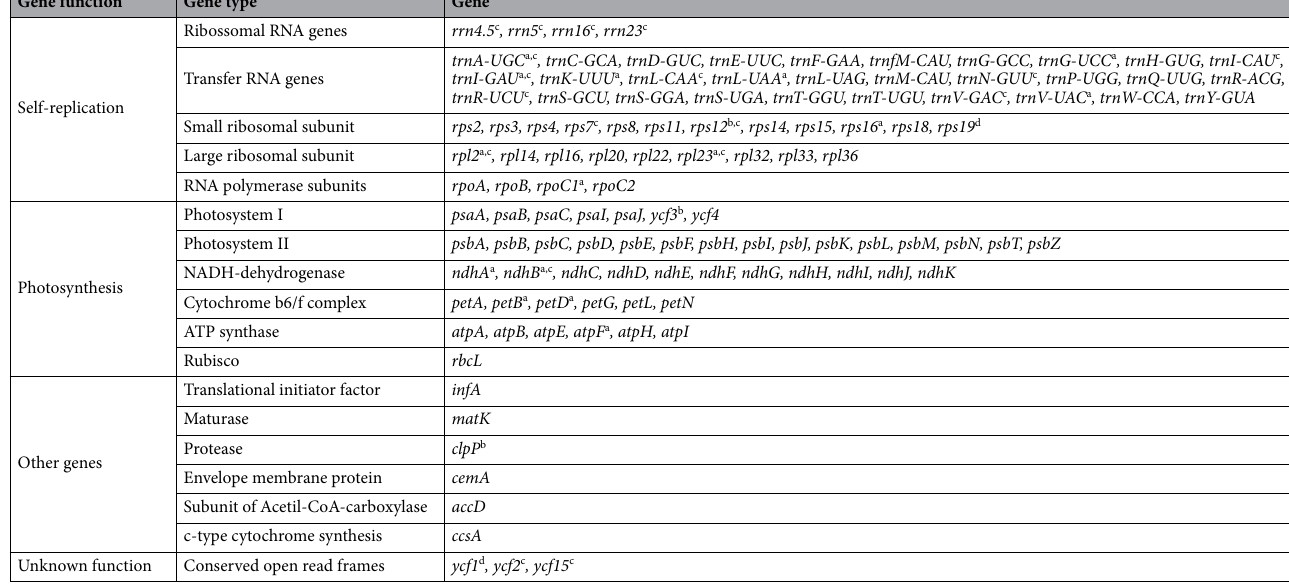
Table 2. Genes encoded by the Mikania species, Ageratina fastigiata , Litothamnus nitidus, and Stevia collina plastomes. a Gene with one intron. b Gene with two introns. c Gene duplicated. d Gene partially